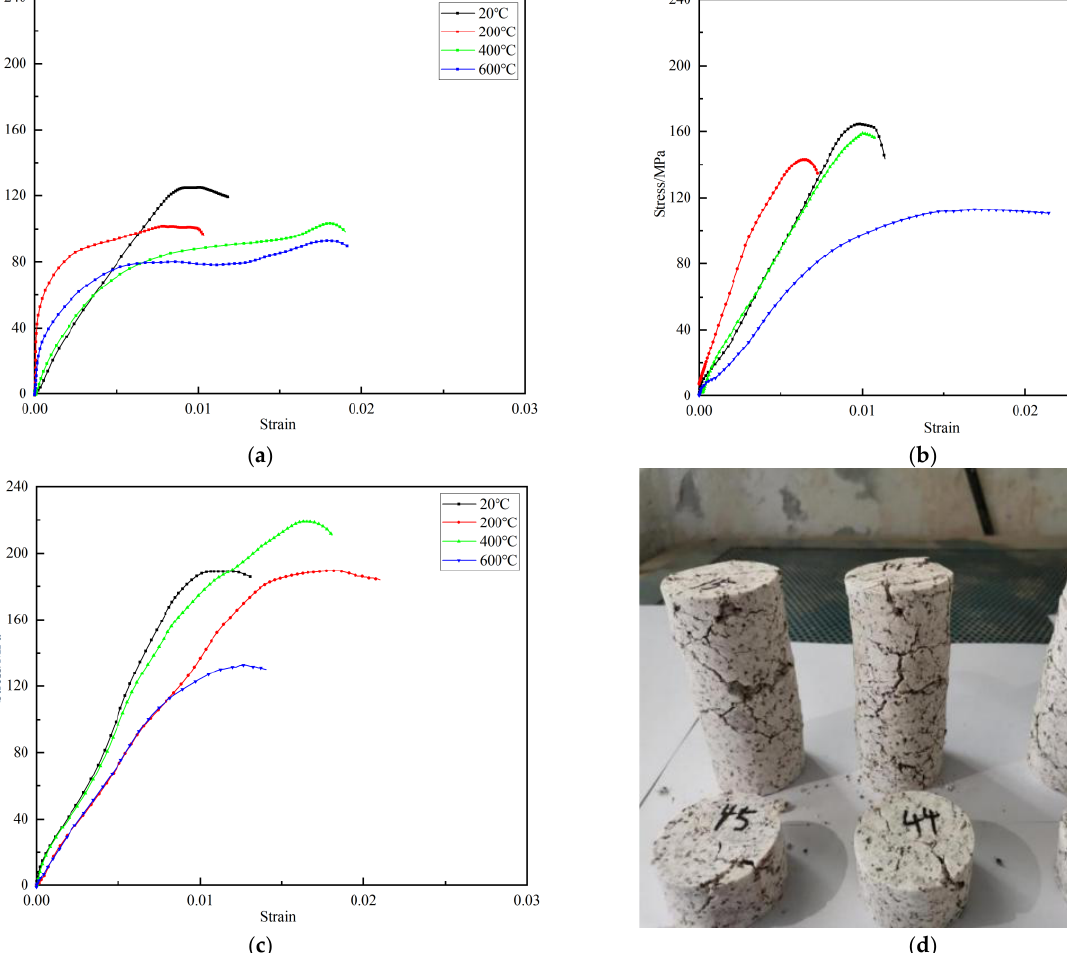
Figure 3. Stress–strain curves at different temperatures with specimens treated at 800 °C. ( a ) Stress– strain curves at different temperatures (5.4 m/s), ( b ) stress–strain curves at different temperatures (8.8 m/s), ( c ) stress–strain curves at different temperatures (11.3 m/s), ( d ) granite specimens treated at 800 °C.